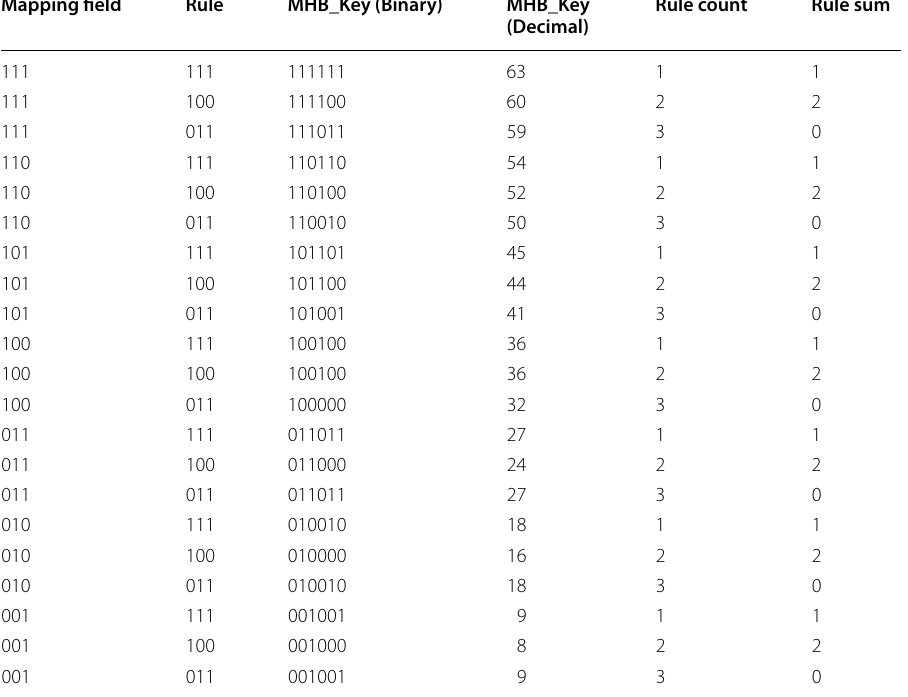
Table 6 Mapping field addition